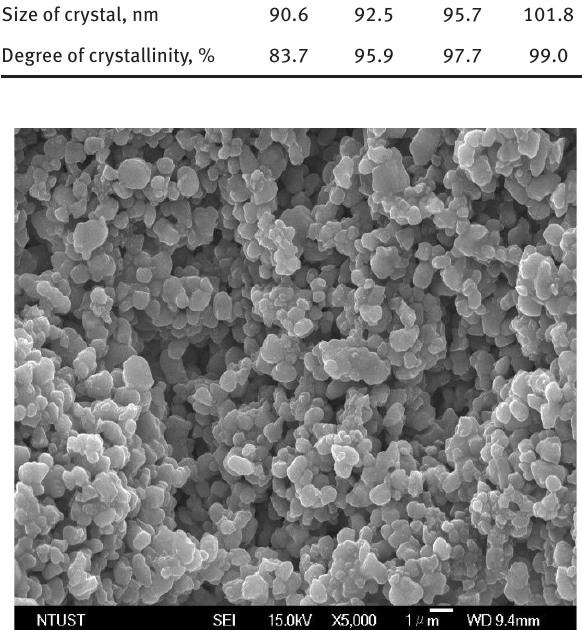
Figure 6: HA applied for grafting collagen was prepared under condition of calcine temperature 1000°C, bovine powder/ and pH 11.